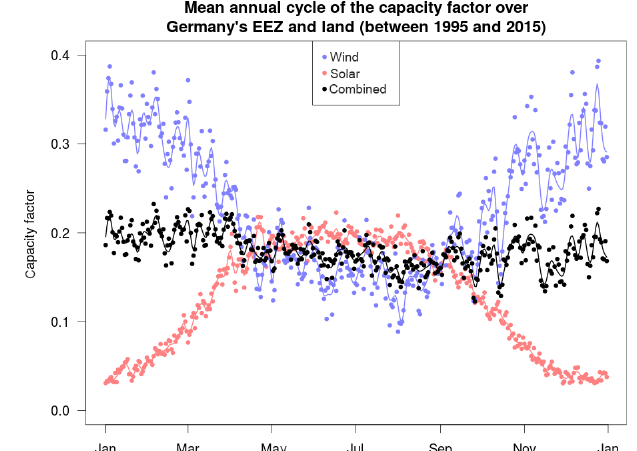
Figure 4. Seasonal cycle of the capacity factors for wind and PV for Germany. The dots represent daily average values for the analysis period of 21 years. The lines are centered 11d running means. The daily resolution is shown to illustrate the remaining variability in a 21 year dataset for both parameters. A longer analysis period would result in additional smoothing.